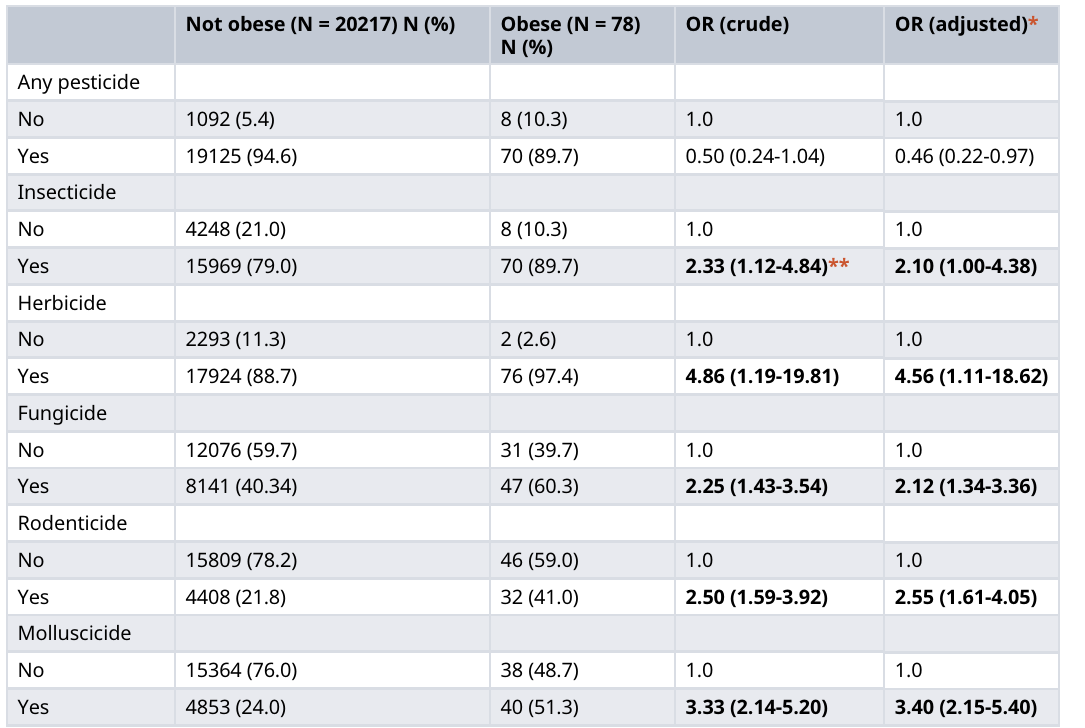
Table 2. Association (OR) between different types of pesticide and